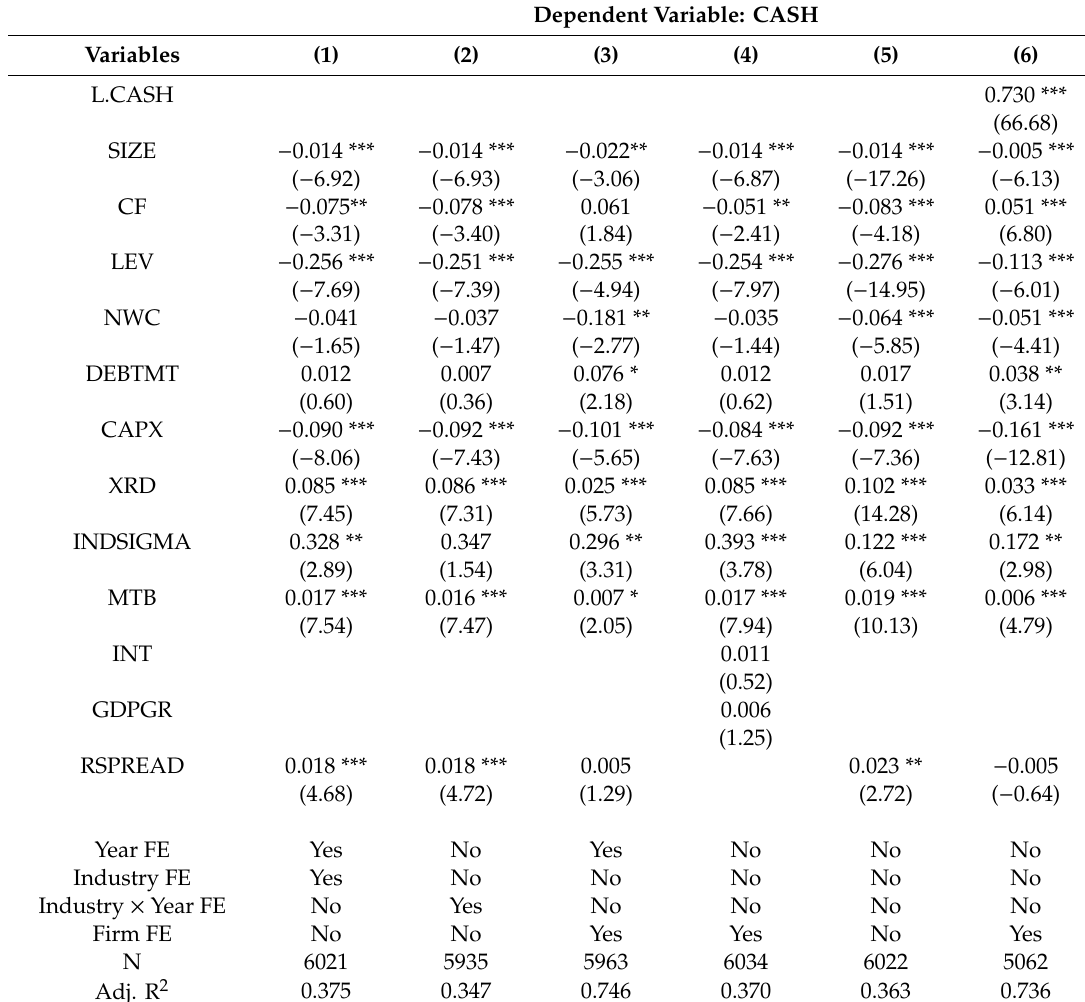
Table 6. Determinants of Cash